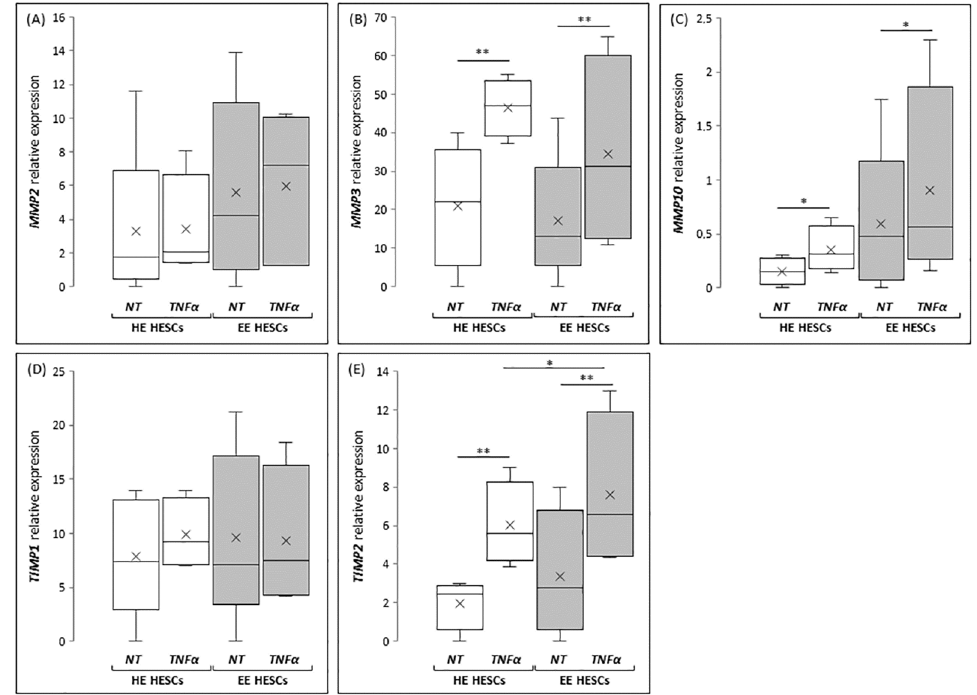
Figure 4. MMP2 ( A ), MMP3 ( B ), MMP10 ( C ), TIMP1 ( D ), and TIMP2 ( E ) mRNA expression in endometrial stromal cells prepared from healthy (HE-HESCs) or eutopic (EE-HESCs) endometrium. Graphical diagram is plotted as box-whisker plots, where boxes show the interquartile range with median and mean values, and whiskers represent min and max confidence intervals. Data represent value obtained by 2 −ΔCt method. * p < 0.05; * p < 0.01.